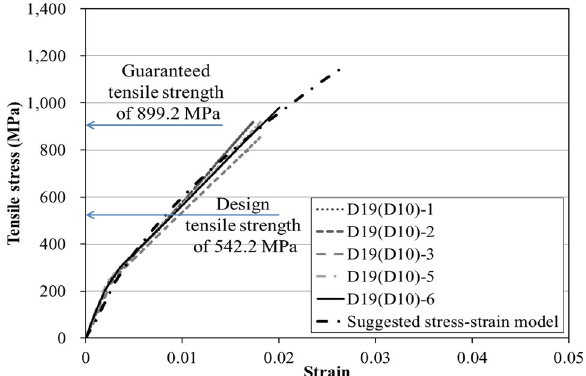
Fig. 11 Tensile stress–strain for suggesting design modulus of elasticity of the GFRP hybrid